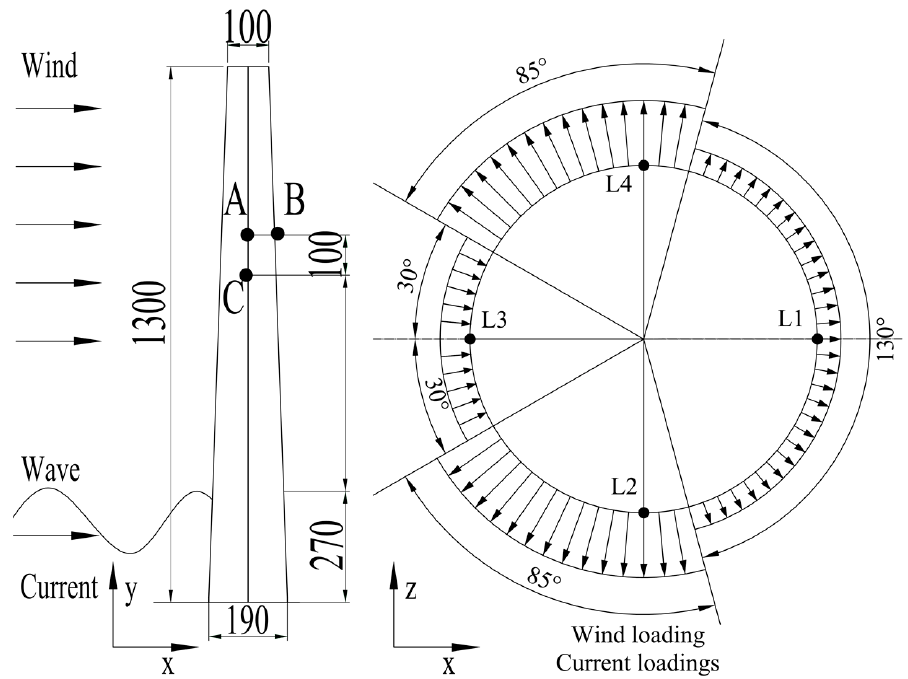
Figure 2. Dimensions of the wind turbine tower and wind, current and wave loading profile.